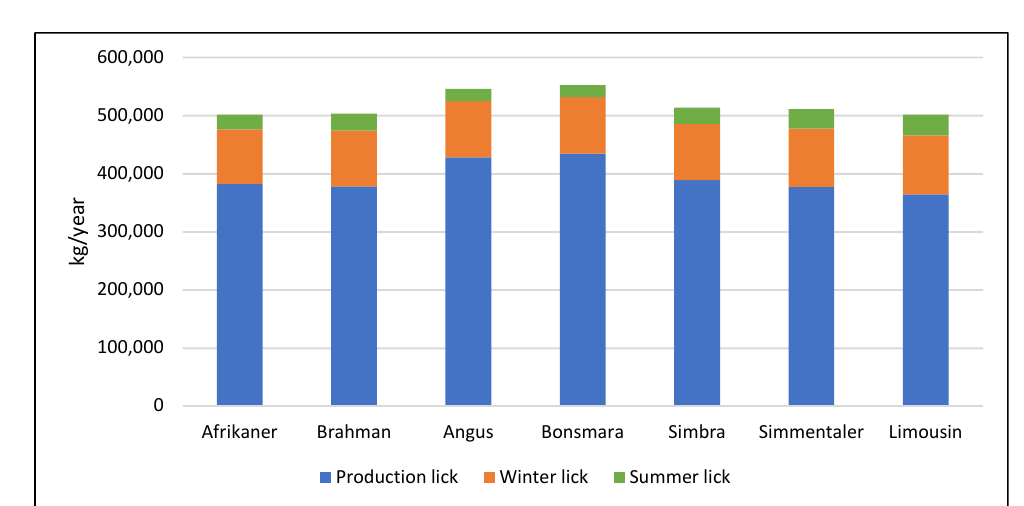
ff erent breeds. Source: Own Figure 1. Annual lick requirements of the different breeds. Source: Own calculations. Figure 1. Annual lick requirements of the di